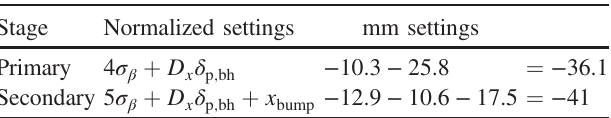
TABLE V. Operational settings of the baseline design of the SPS off-momentum collimation system. Optics parameters refer to the Q20 optics (see Table IV).